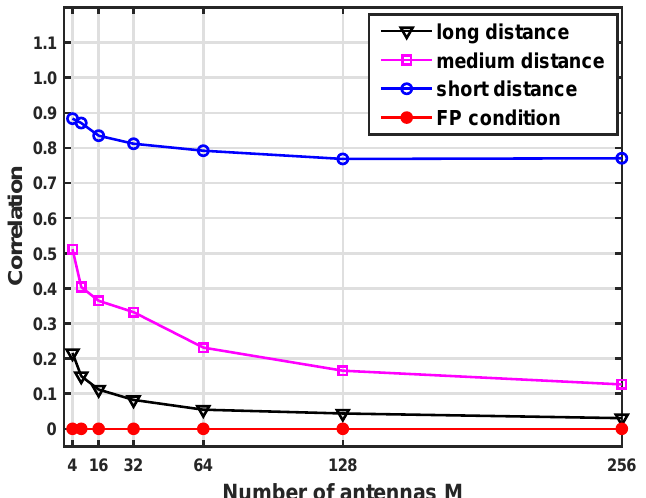
Figure 11. Channel correlations in a practical measurement scenario with different antenna